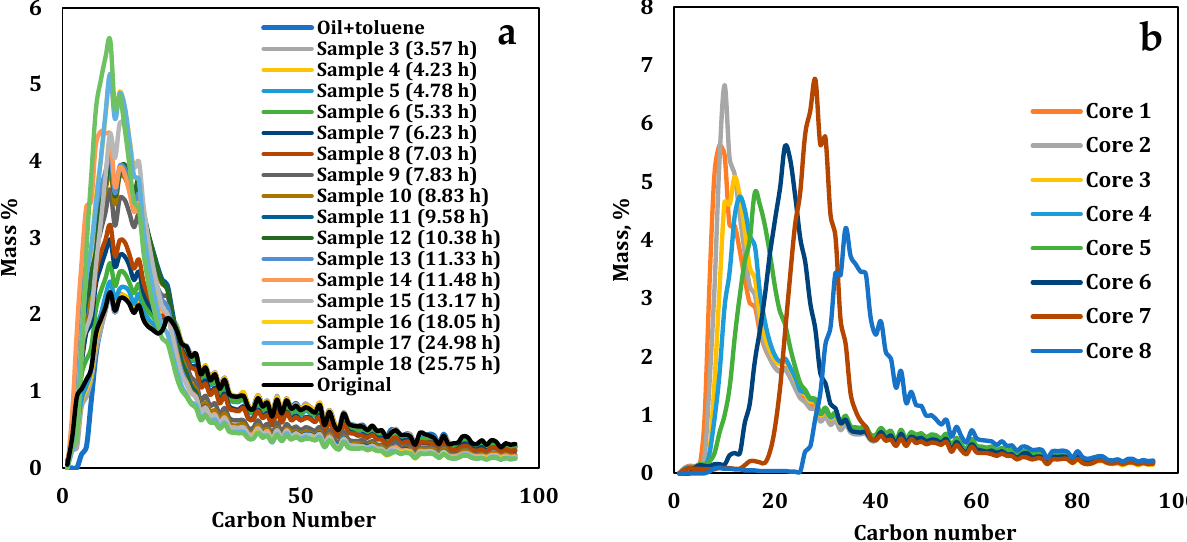
Figure 21. Carbon number obtained from ( a ) produced oil and ( b ) oil extracted from the core sam- ples.